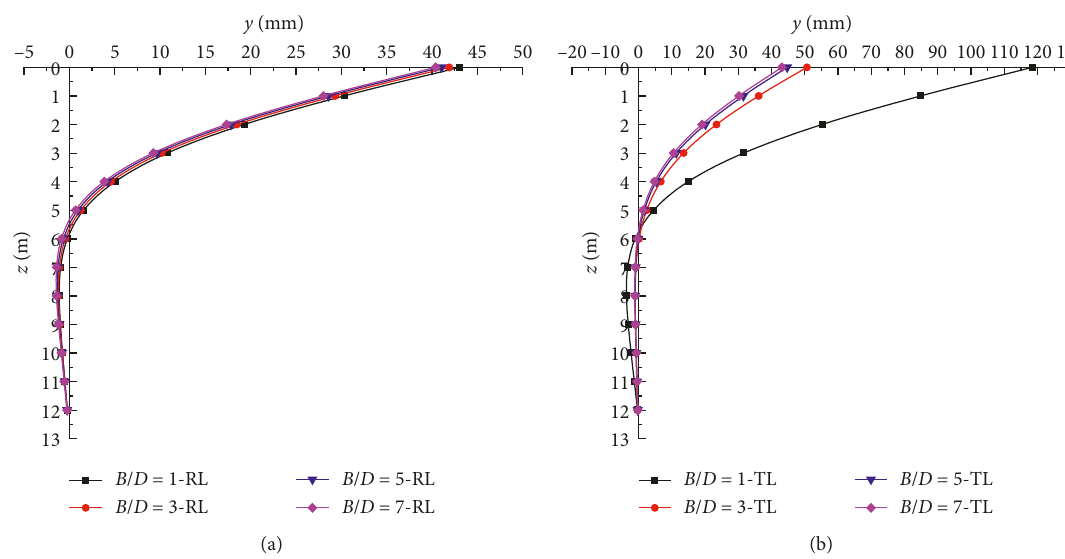
Figure 17: Pile deflection versus depth relationships under different loading directions for the 1V:1H slope at H loading. (b) Toward loading.